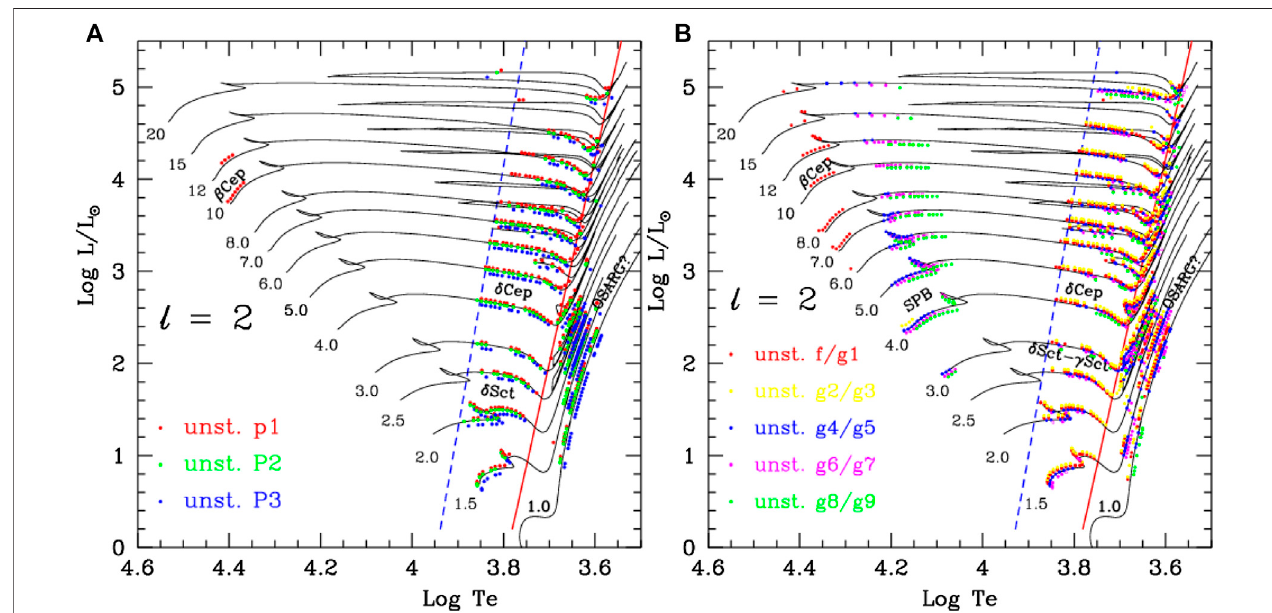
FIGURE 4 | Pulsationally unstable (colored, fi lled circles) low-degree ( l (cid:2) 2 ) non-radial low-order p-modes (panel a) and g-modes (panel b) in the H-R diagram for evolutionary models of 1 – 20 M ⊙ stars. Each color isshifted aline-width in the x -/ y -direction, in order to be able tosee each color. The blue dashed line and red solid line are, respectively, our theoretical blue and red edges of the Cepheid instability strip. The locations of the main types of variable stars are indicated.